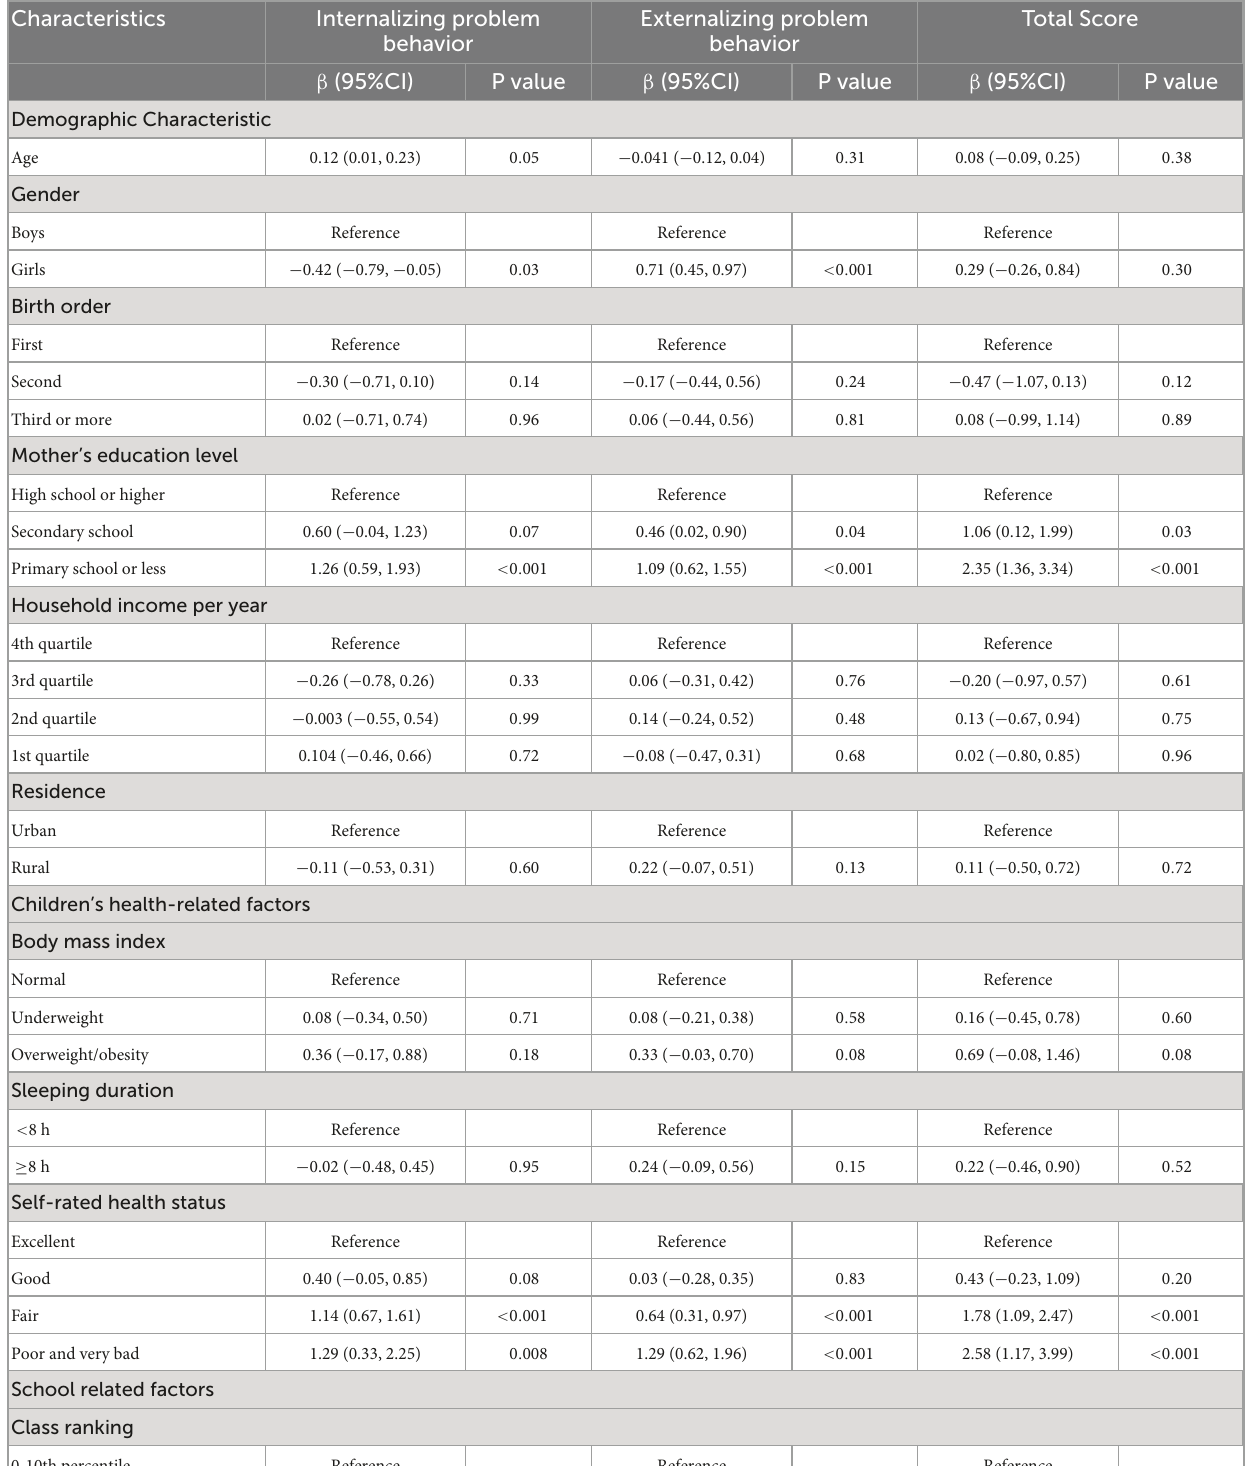
TABLE 4 Multivariable linear regression analysis of the associated factors with problem behavior in the imputed dataset ( n = 2,448).